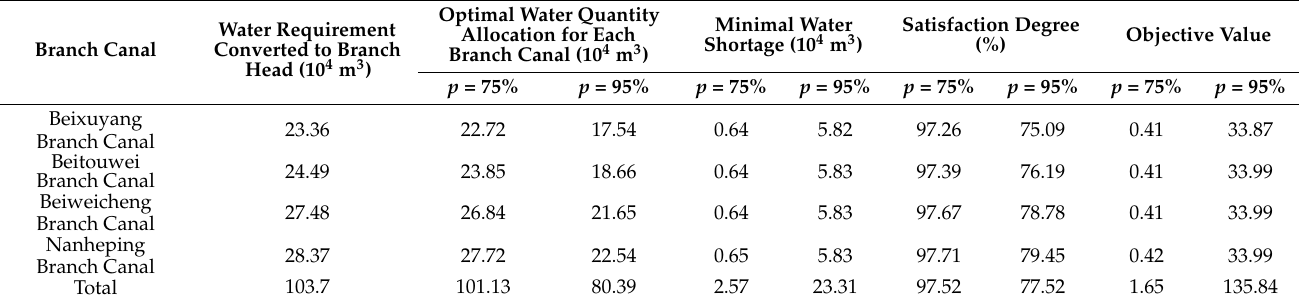
Table 4. Optimal water quantity allocation of each branch canal in the Hengliu Main Canal system during the ponding period of rice in different year types using DP-mode.